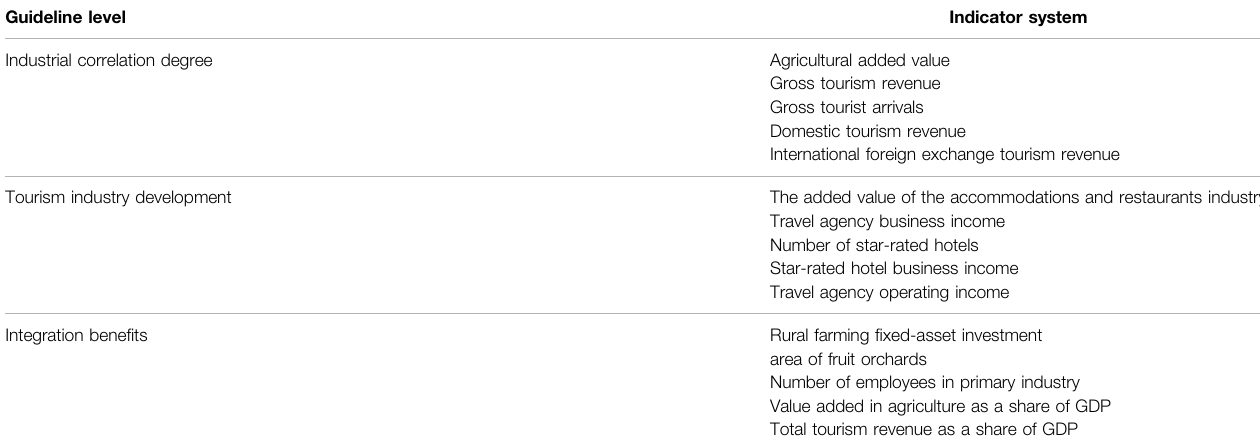
TABLE 1 | Agro-tourism integration index system. Guideline level Indicator system Industrial correlation